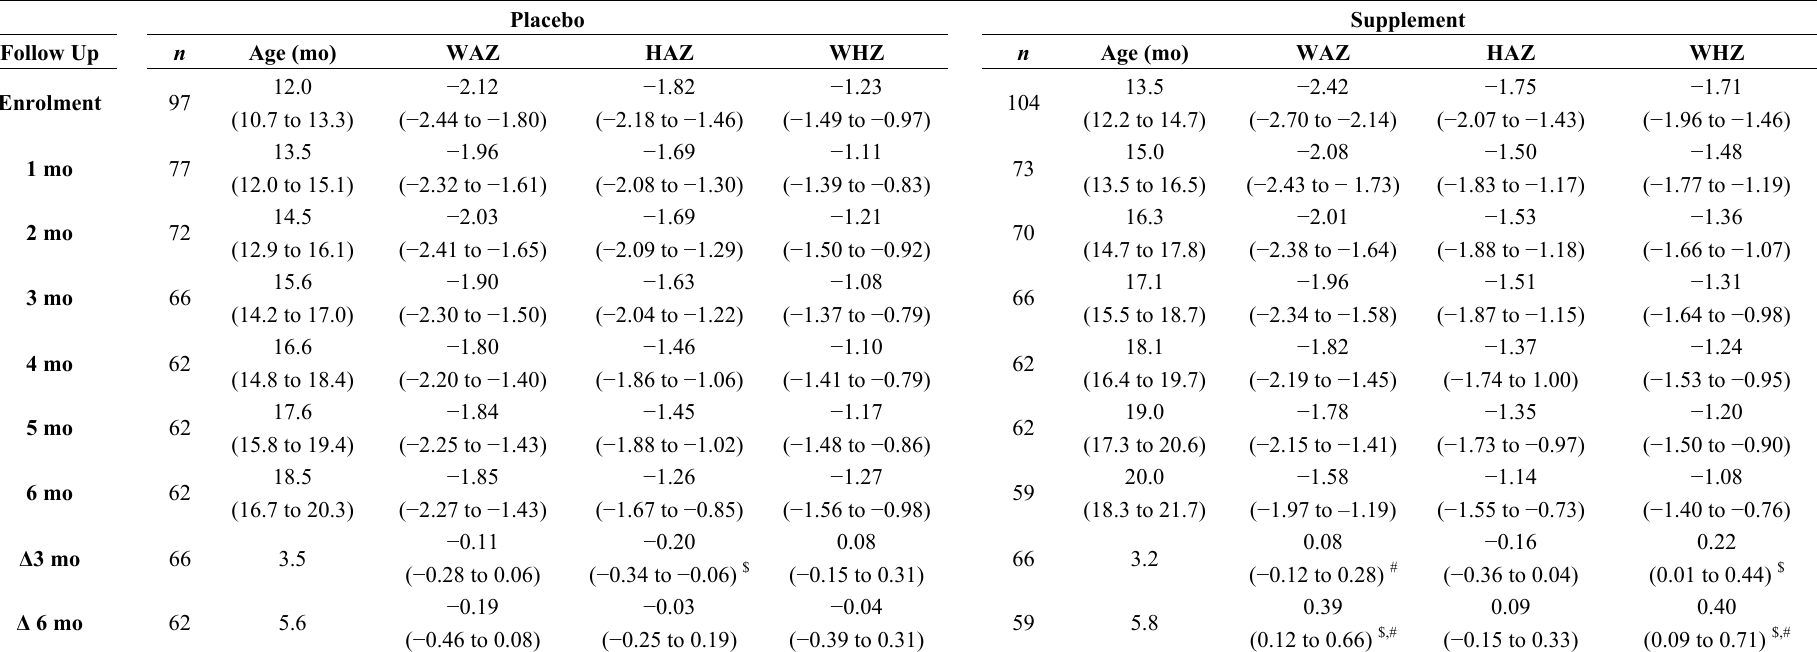
Table 4. Anthropometric indices of the children during intervention